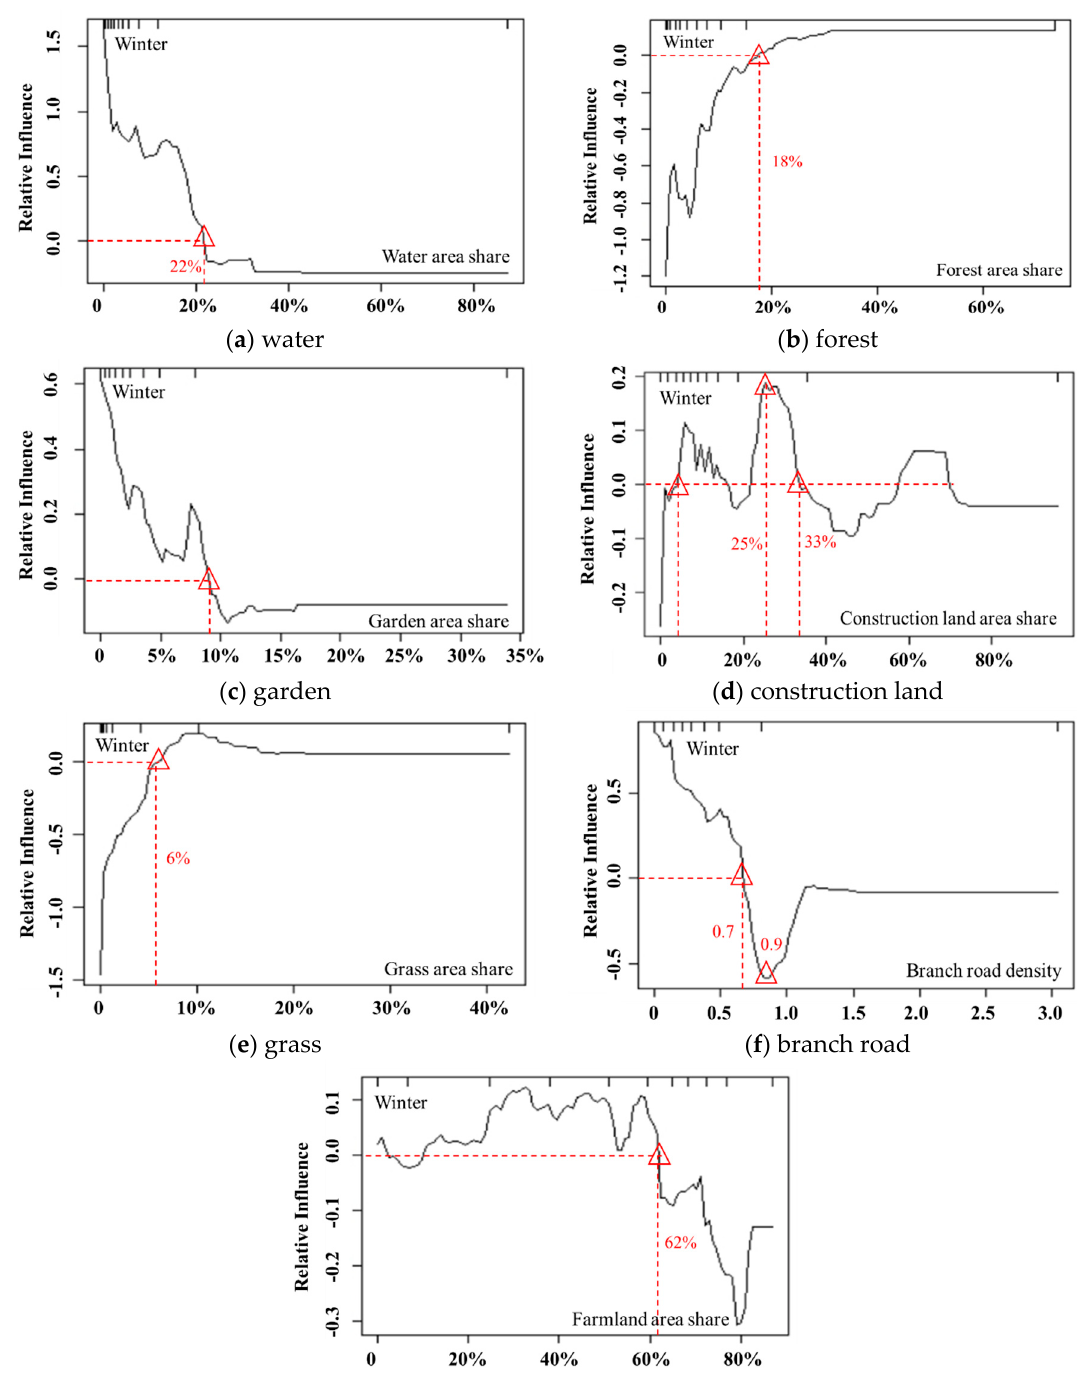
Figure 12. The influence of the main factors (concentration rate >10%) on PM 2.5 in